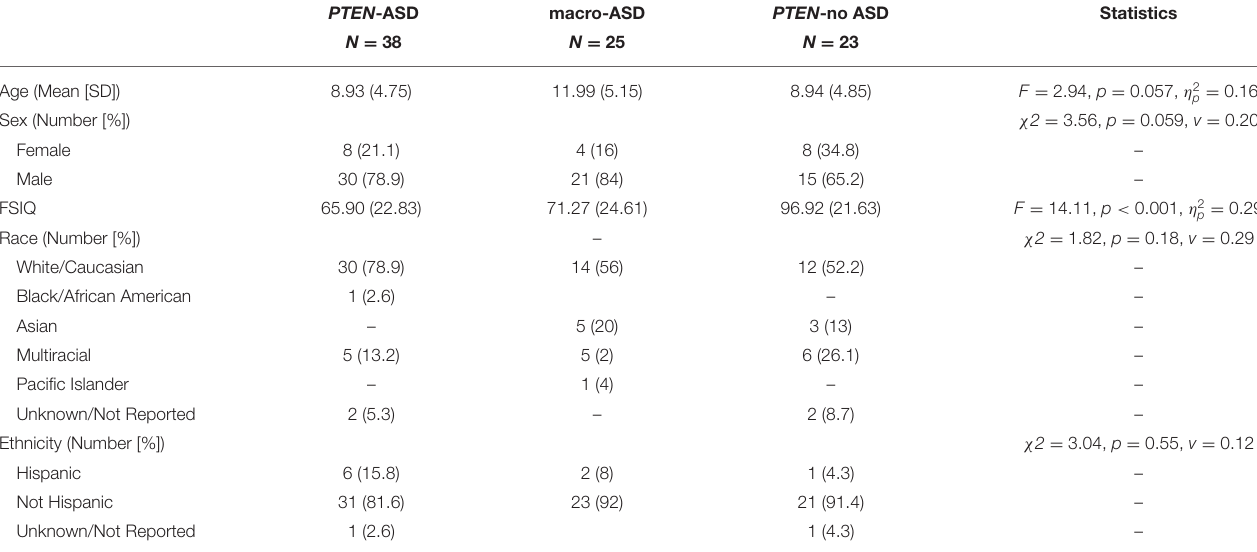
TABLE 1 | Demographic characteristics.